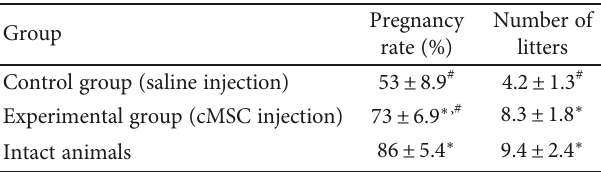
Table 3: The pregnancy rate and number of litters in o ff spring of females fertilized in natural estrous cycle.